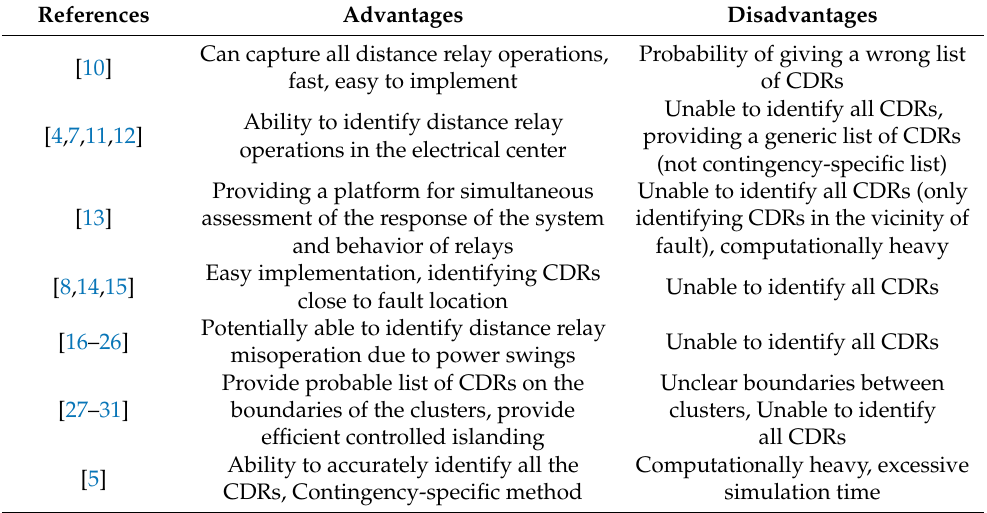
Table 1. Advantages and disadvantages of the methods proposed in the